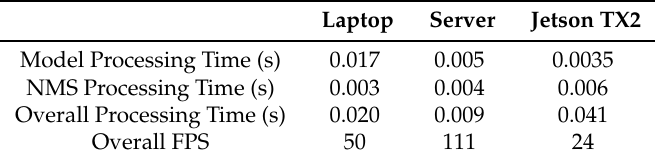
Table 2. Processing time of Rotation-SqueezeDet in different platform.